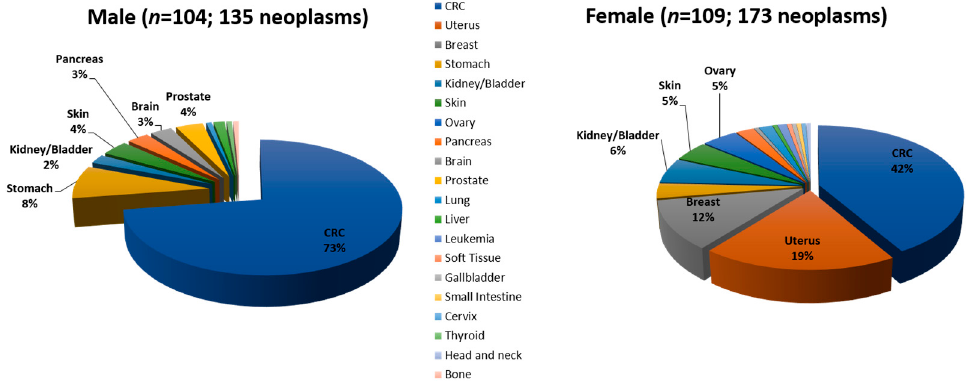
Figure 3. Spectrum and frequency of tumors by gender in Group 1.